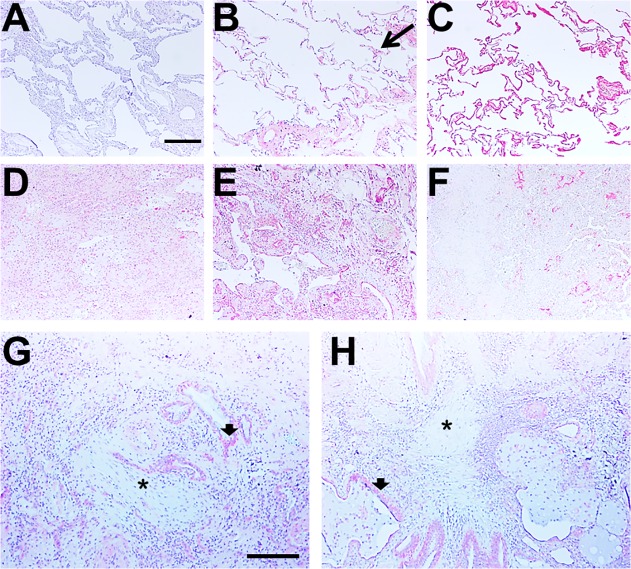
The distribution of PTX3 and SAP in COPD and pulmonary fibrosis lung tissue.Human lung tissue from A-C) COPD patients or D-H) pulmonary fibrosis patients was stained with A) control rabbit antibodies, B, D, E, G and H) anti-PTX3 or C and F) anti-SAP antibodies. Tissues were counterstained with hematoxylin. Positive staining is identified by red color, and nuclei are counterstained blue. Bar is 0.2 mm. Long arrow indicate PTX3 staining in an alveolar septum, short arrow indicates PTX3 staining in lung epithelium, and asterisks indicate fibroblastic foci.